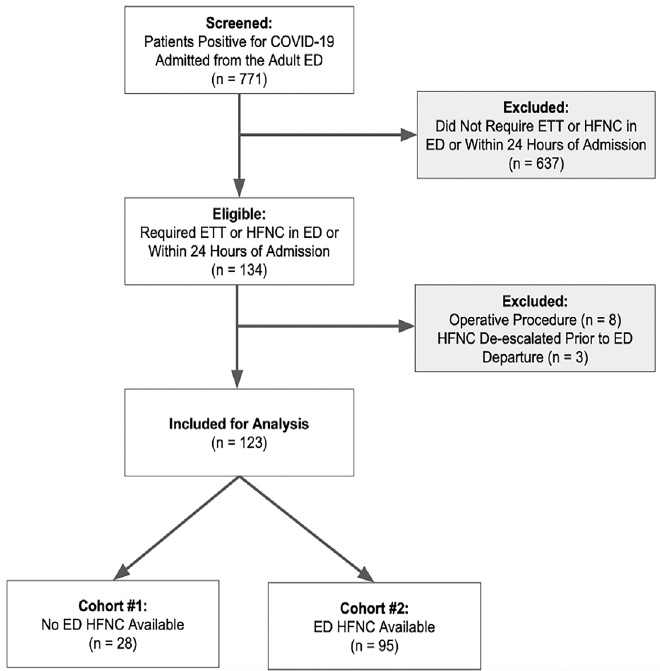
Figure 1. Flow chart of patient screening, eligibility, inclusion,